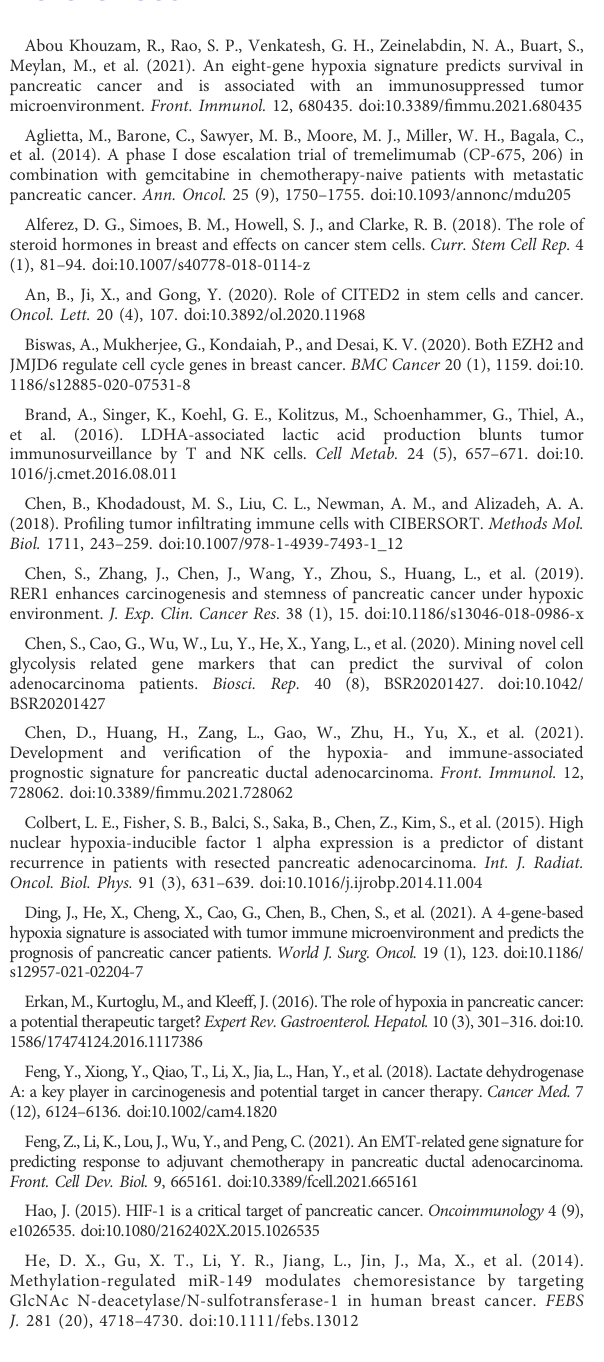
SUPPLEMENTARY FIGURE S1 Top 3 hypoxia genes correlated with mRNAsi. Green represents the top 3 genes negatively correlated with mRNAsi, while red represents the top 3 genes positively correlated with mRNAsi. SUPPLEMENTARY FIGURE S2 Identi fi cation of the optimal genes used to develop the prognostic signature by the LASSO regression algorithm. (A) Selection of the optimal parameter (lambda) in the LASSO model. The two vertical lines